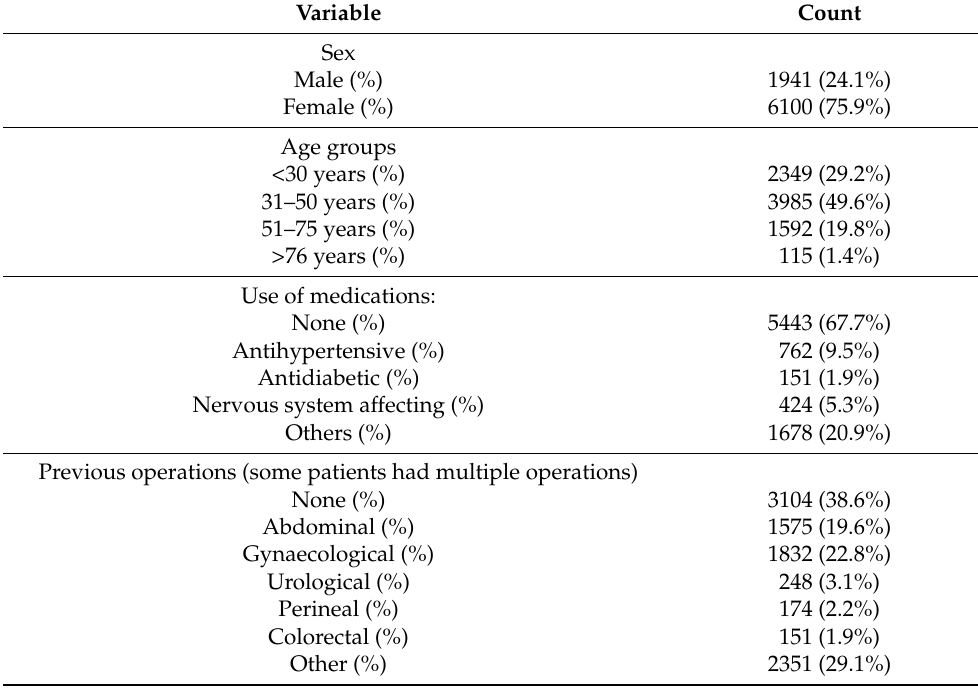
Table 1. Demographics of population included in the